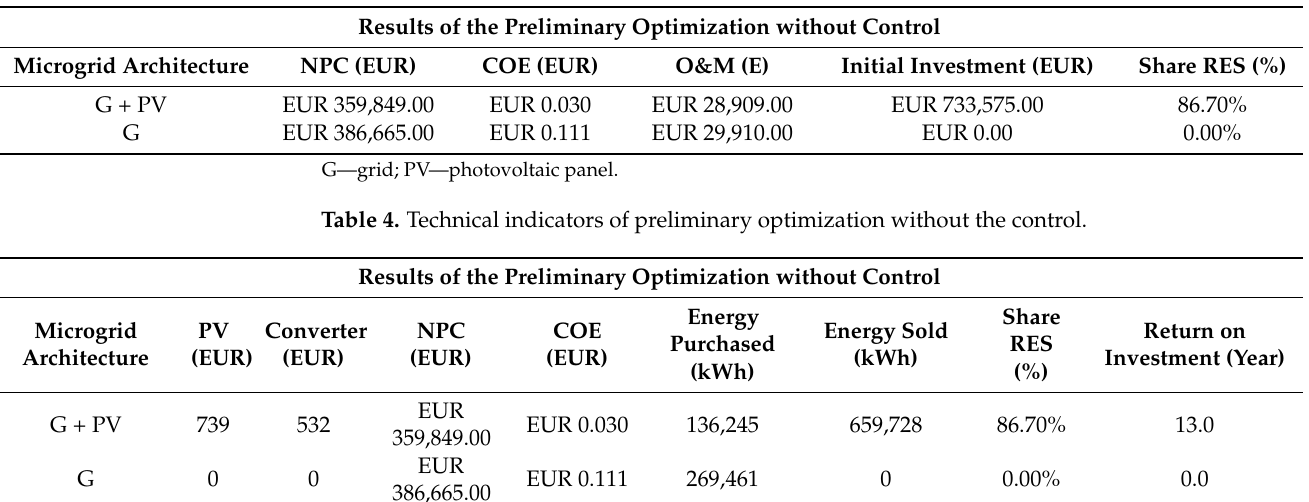
Table 3. Economic indicators of preliminary optimization without the control.